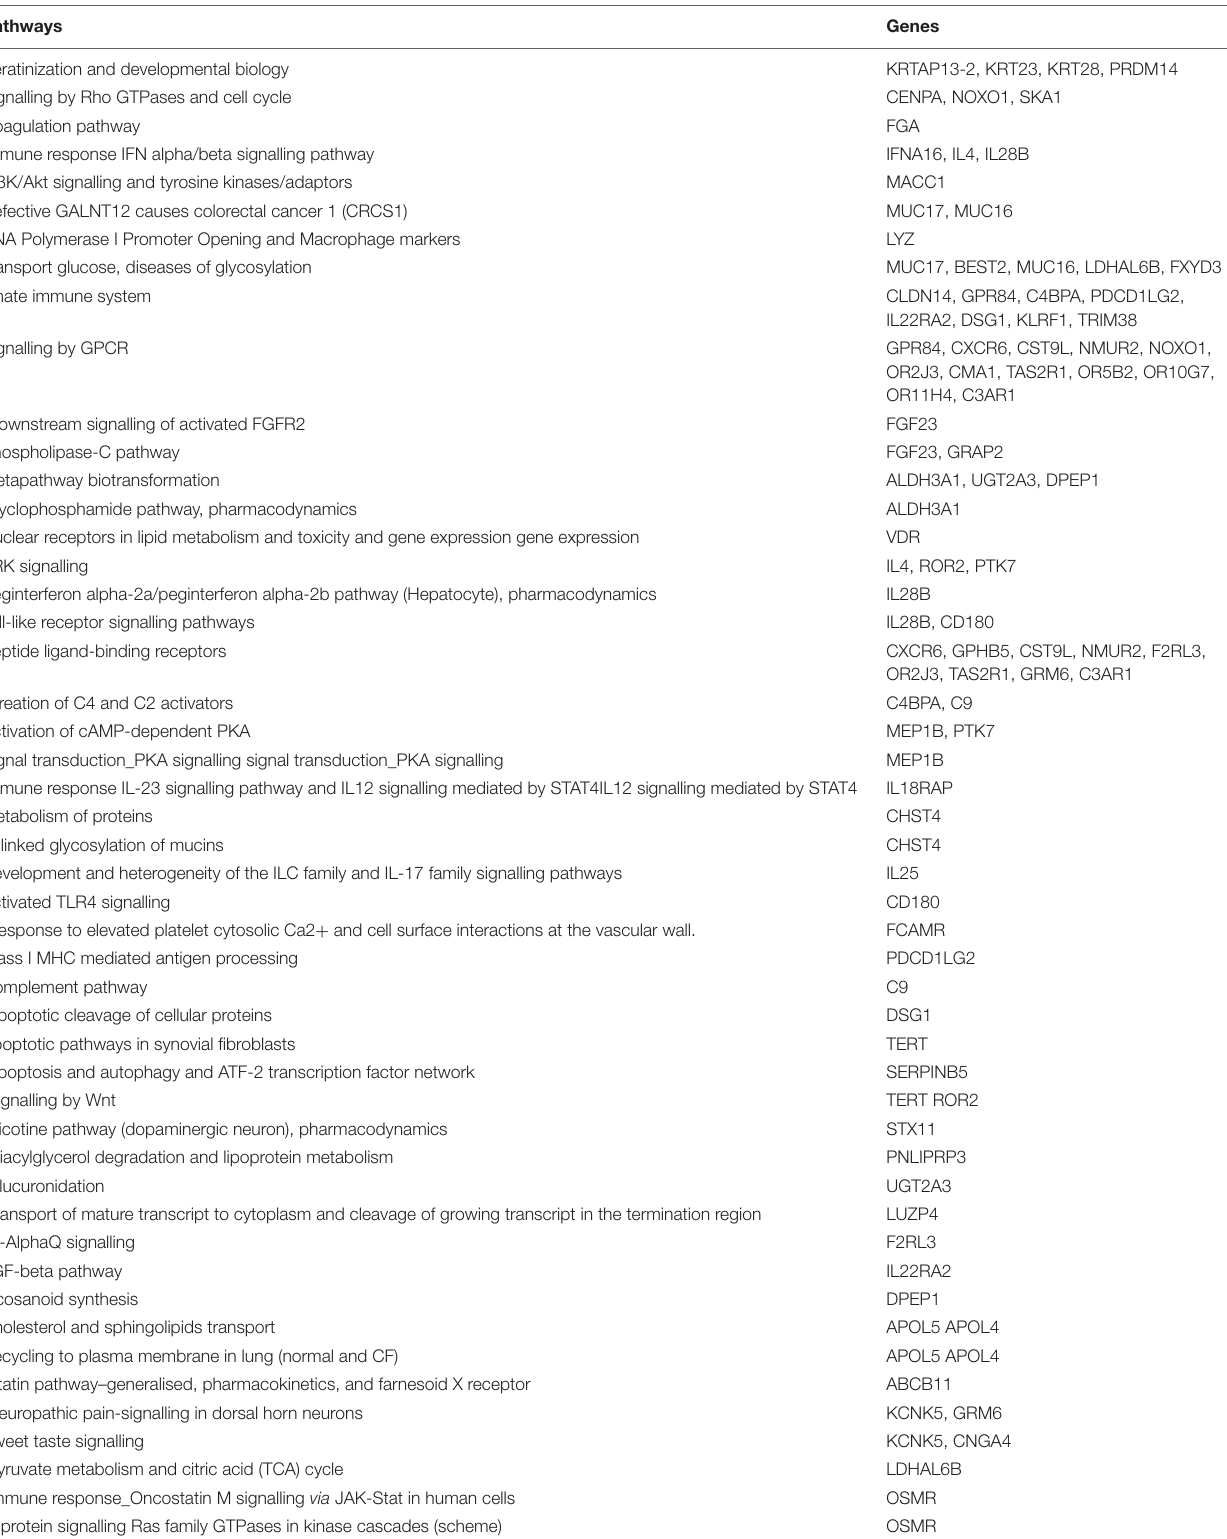
TABLE 3 | Pathways where our co-expressed mRNA are involved. Pathways Genes Keratinization and developmental